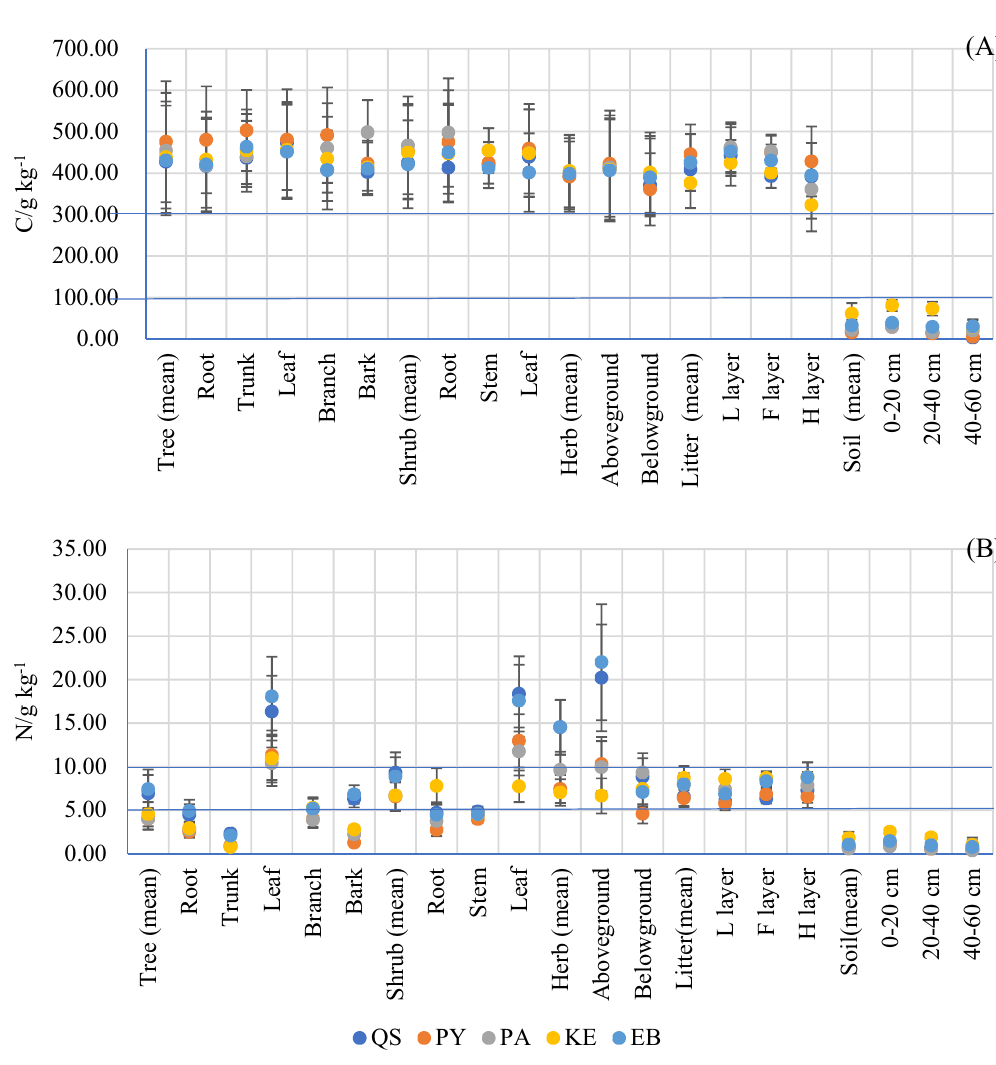
Figure 2. C (g kg −1 ) and N (g kg −1 ) concentrations in the plant components, litter layer and soil in various forests in the central Yunnan Plateau. Error bars mean standard